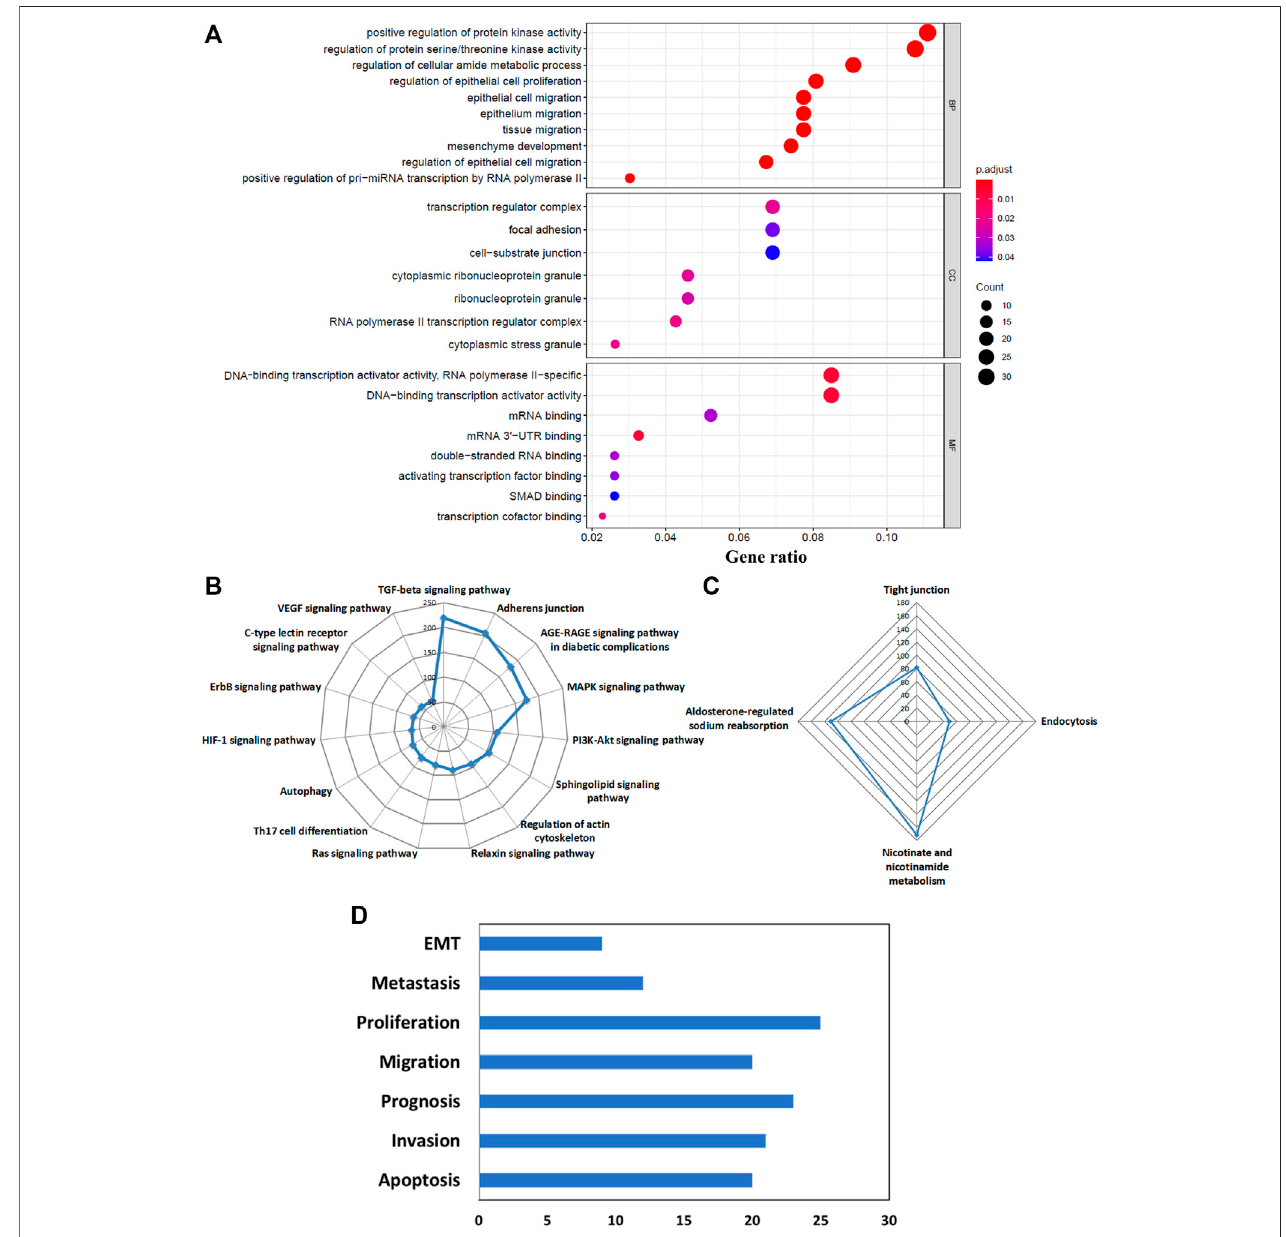
FIGURE 5 | Biological functions and pathways of the predicted target RNAs of DE-RBPs. (A) Bubble plot shows the enriched GO terms of upregulated coding targets:biologicalprocesses(BP),CellularComponent(CC),andmolecularfunctions(MF). (B) RadarplotshowsKEGGpathwayanalysisofupregulatedcodingtargets. (C) Radar plot is shows KEGG pathway analysis of downregulated coding targets. (D) Altered pathways represent cancer hallmarks for predicted lncRNA targets from the LncSEA database.